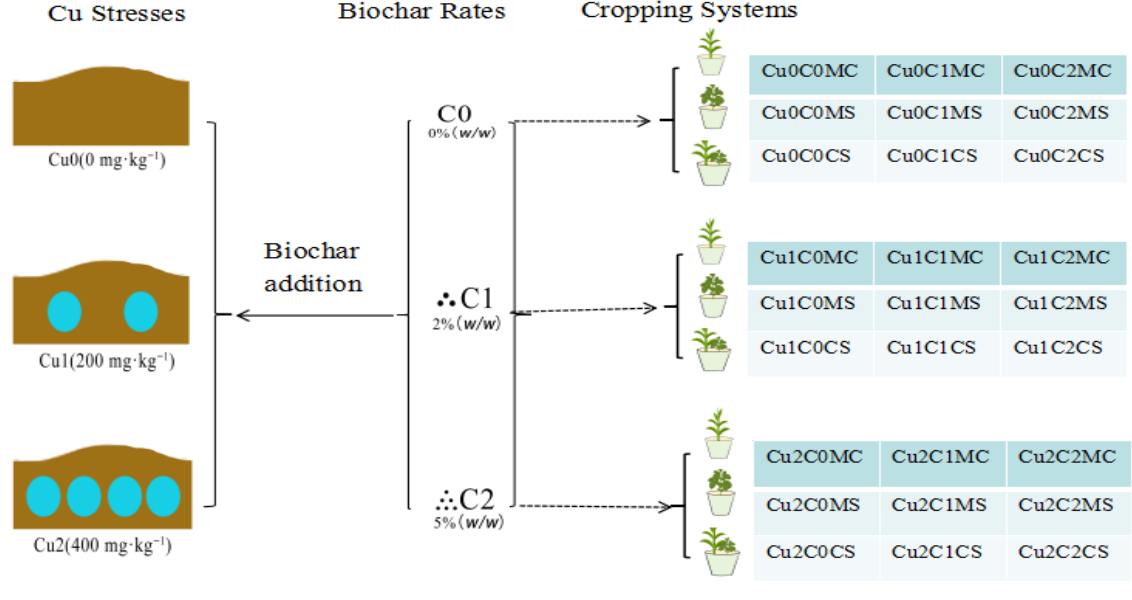
Table 4. Properties of the biochar.